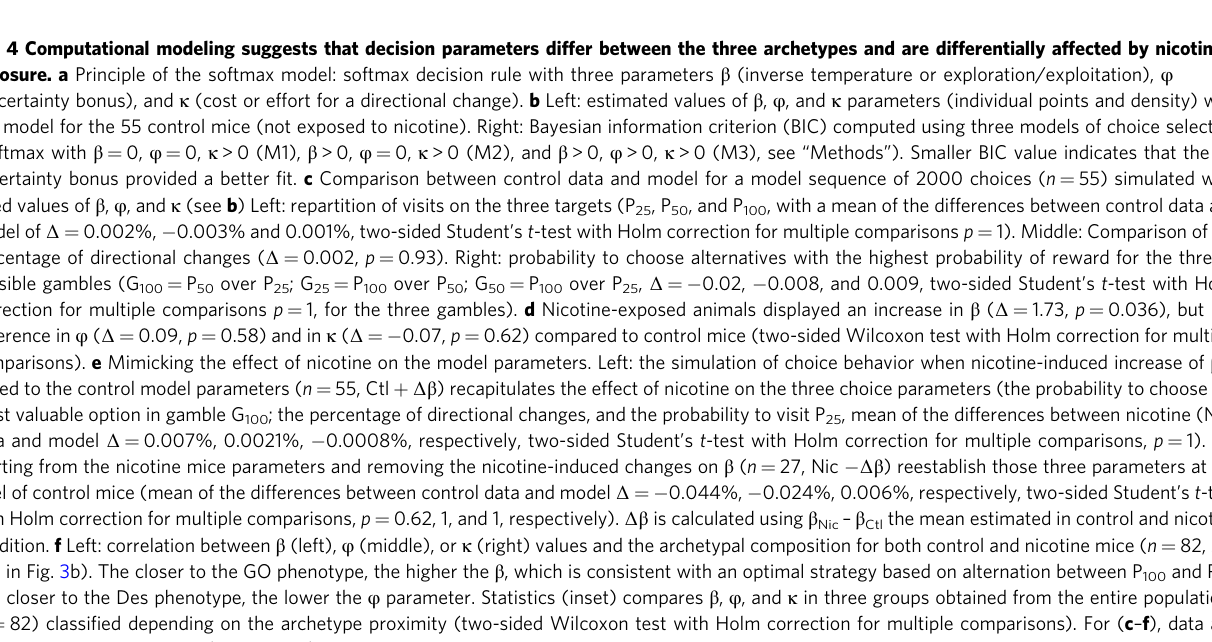
(Fig. 5e), as observed with chronic nicotine. Photo-inhibition of VTA DA neurons, however, did not signi fi cantly affect the exploration/exploitation trade-off parameter β (Fig. 5e). For each pair of ON/OFF experiments, we also estimated the effect of the photo-stimulation on our seven main behavioral measures (Fig. 1d – f) and β parameter by calculating for a given measure ( M ) the difference Δ = M ON − M OFF. These differences were compared with the net effect of nicotine obtained for each of these parameters by subtracting the mean control value from the mean effect of nicotine (Supplementary Fig. 6e, red).